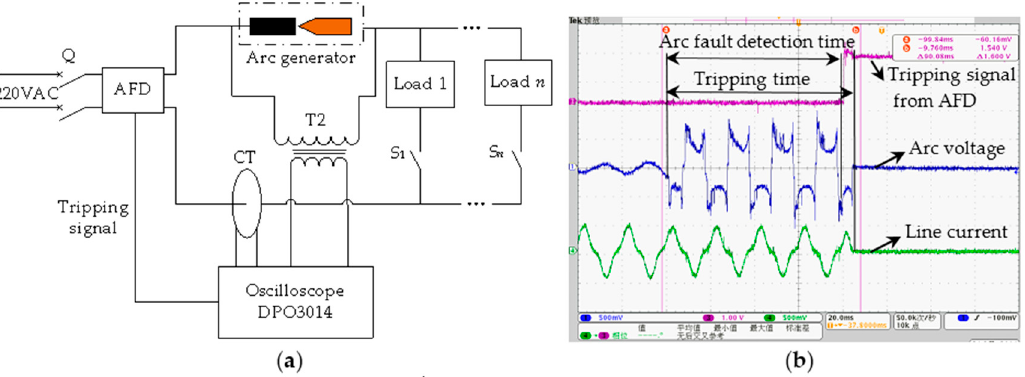
Figure 20. Tripping test: ( a ) schematic; ( b ) results. Figure 21. Tripping test: ( a ) schematic; ( b ) Table 4. Test results under typical loads.